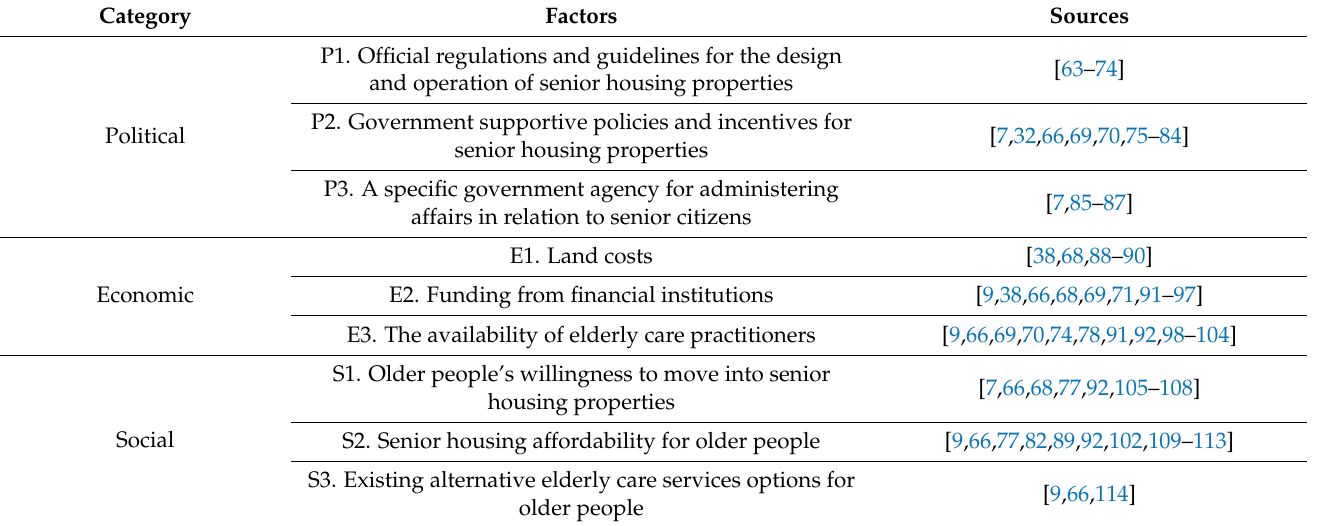
Table 3. Political, economic, and social factors influencing the development of senior